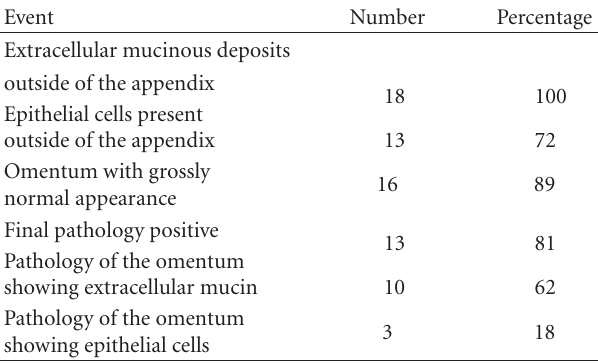
Table 4: Summary of pathological